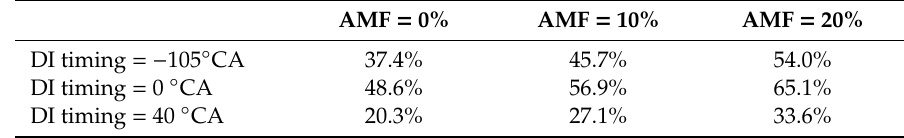
Table 4. Decrease of NO emissions with variation of DI timing and AMF based on original